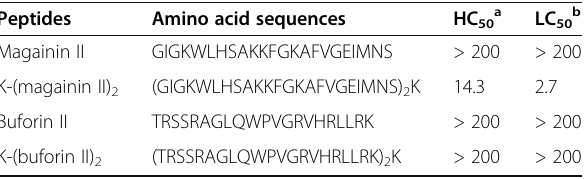
Table 1 Amino acid sequences and cytotoxic activities of peptides used in this study Peptides Amino acid sequences HC